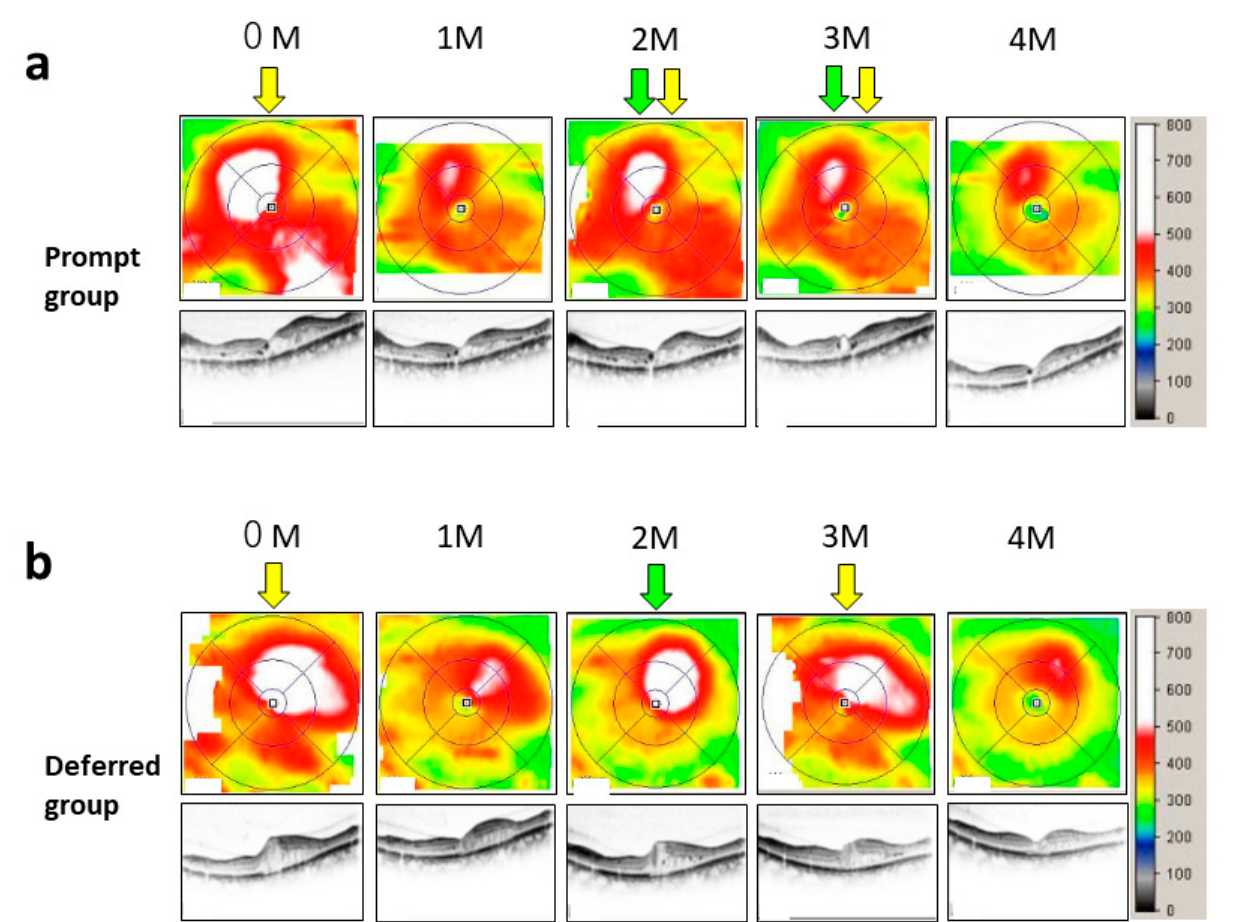
Figure 1. Time course of optical coherence tomography (OCT) images in thickness map and cross section was shown as the representative case in the prompt group ( a ) and in the deferred group ( b ). Green and yellow arrows indicate the timing of the application and actual injection of anti-VEGF agents, respectively, for the treatment for diabetic macular edema (DME). Scale bar indicates the retinal thickness corresponding to the false color.